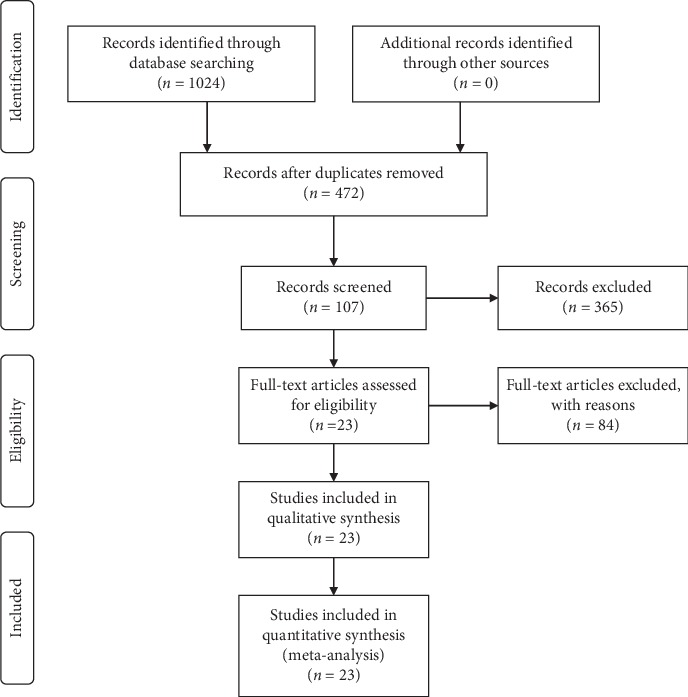
Flow diagram of the literature selection process.